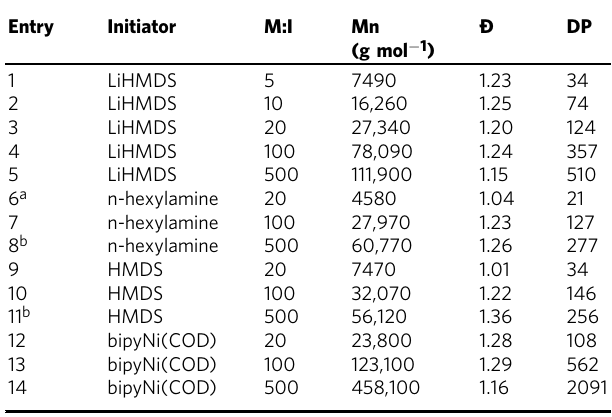
Table 1 Characterization of poly-BLG prepared using different